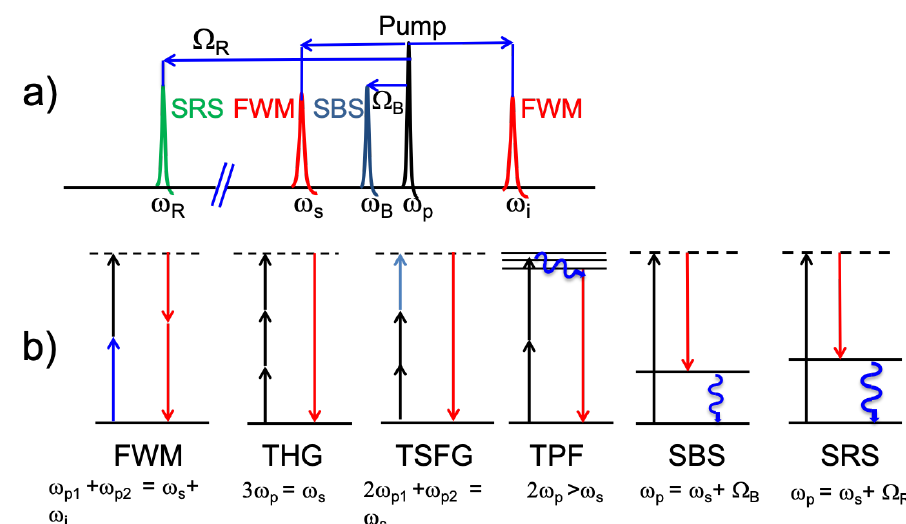
Figure 2. ( a ) Illustration of the infrared spectra observed when nonlinear phenomena are generated. ( b ) Schematic representation of the energy levels of different nonlinear processes (from left to right): FWM, THG, TSFG, TPF, SBS and SRS . Real energy levels are denoted by solid lines (non-parametric processes) while virtual states are indicated by dashed